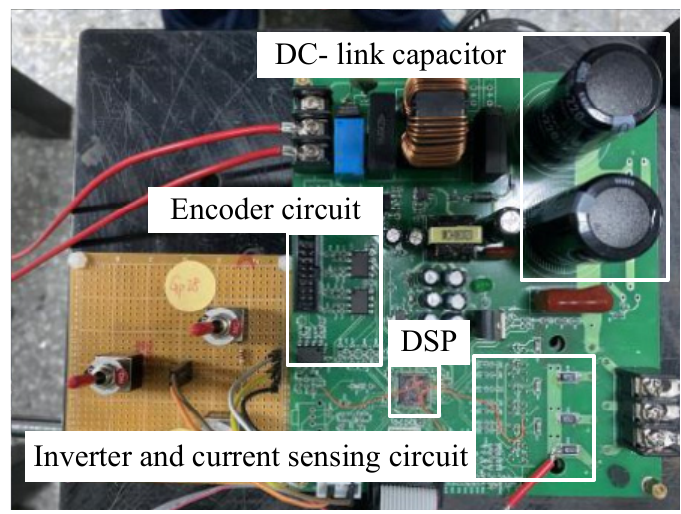
Figure 10. Photograph of main circuits.